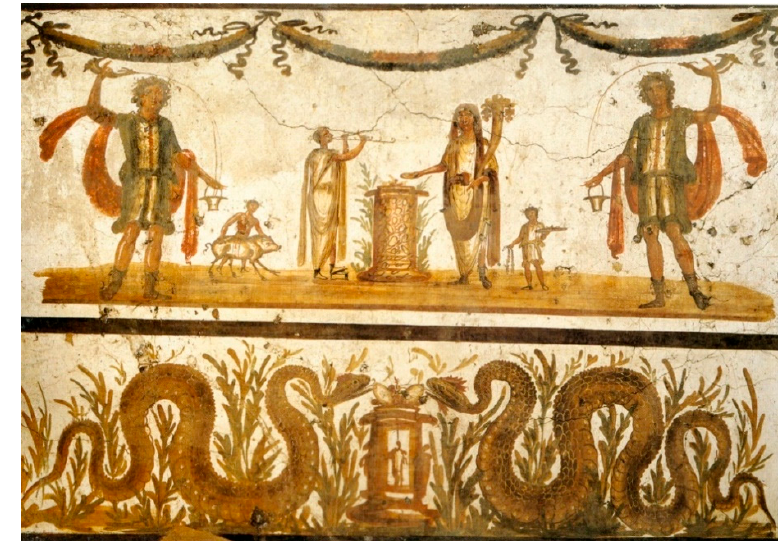
Figure 1. Wall-painting of lares flanking a sacrificial scene led by a genius , and three attendants (including one holding a garland on the right), atop two snakes approaching a circular altar. Naples Archaeological Museum, Inv. 8905. (Modified by author, after Fröhlich 1991, Taf. 10.2). Apart from lararia , there are other painted scenes that may have invited religious devotion.